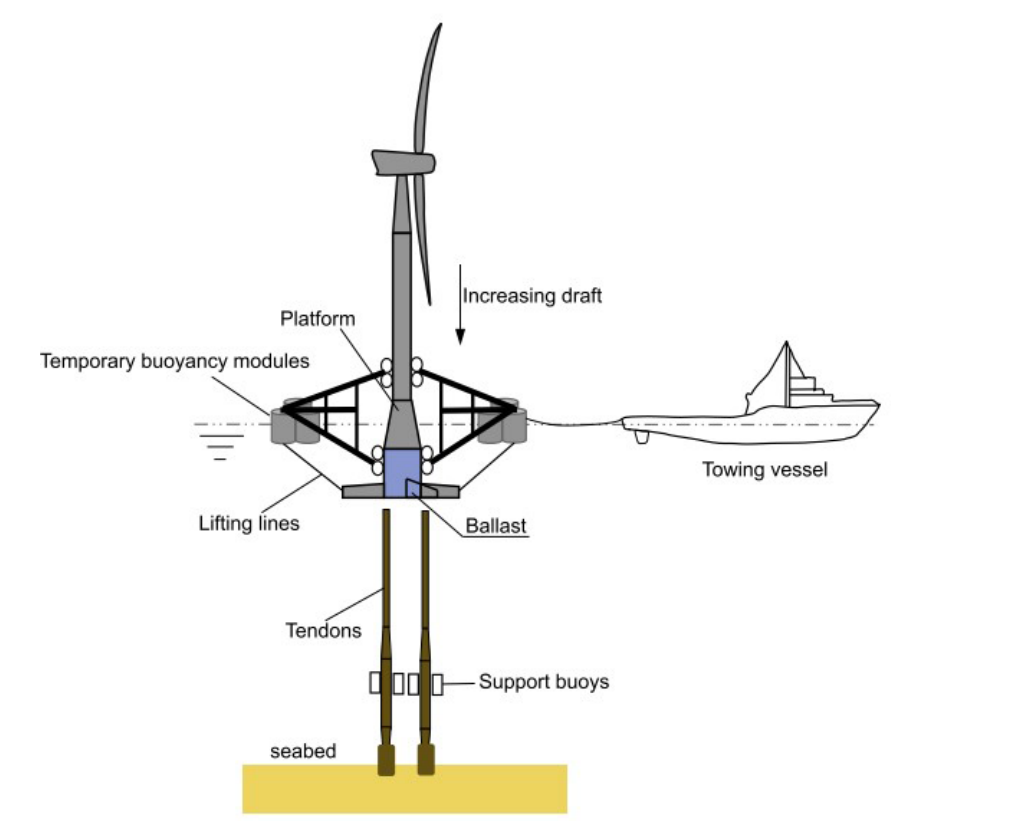
Figure 4. Installation method of an MIT and Enel TLP (Jiang,